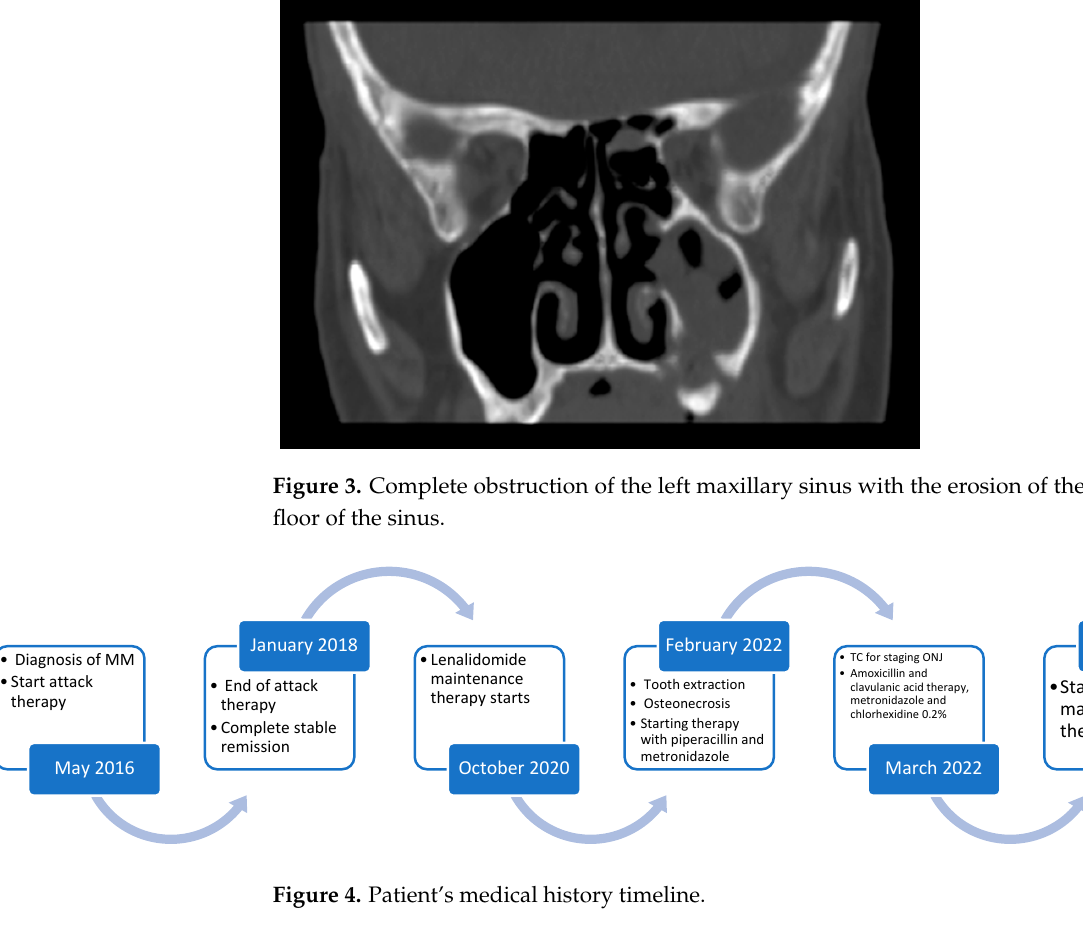
Figure 4. Patient’s medical history timeline .